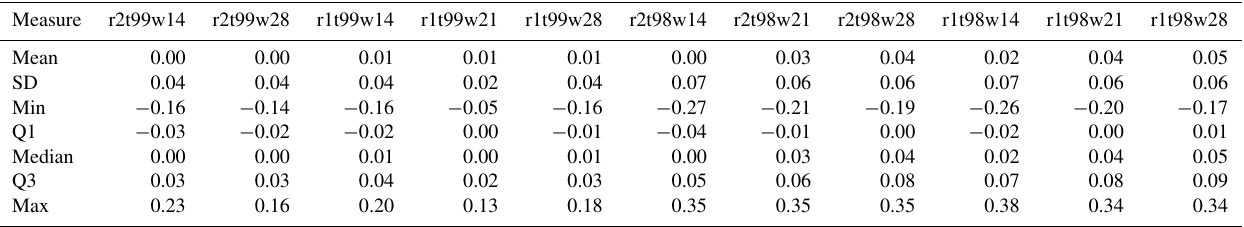
Table F2. Descriptive statistics of the distributions of the difference between the initial parameter combination ( r = 2d ,t = 99p ,w = 21d) and the other combinations. The measures are the same as in Table